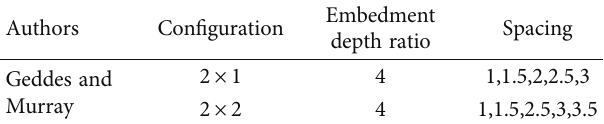
Table 2: Sand properties for group anchor tests.